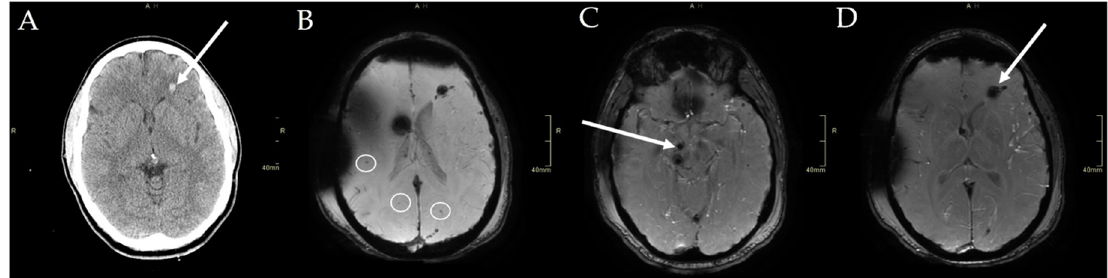
Figure 1. Structural imaging of the reported patient. ( A ) CT imaging showed preserved grey and white matter differentiation with no major mass lesion or mass effect. A small left subcortical frontal hemorrhage was seen and associated with diffuse axonal injury. ( B ) Susceptibility weighted imaging showed punctate foci of parenchymal susceptibility (indicated by the circles) in both cerebral hemispheres, consistent with diffuse axonal injury *. ( C ) Susceptibility weighted imaging revealed a unilateral right sided midbrain injury. There were punctate foci of parenchymal susceptibility from blood in the right cerebral peduncle, as indicated by the white arrow *. ( D ) Susceptibility weighted imaging showed punctate foci of parenchymal susceptibility from blood in the left subcortical frontal lobe, as indicated by the white arrow *. * Black shaded areas are a result of motion artifact.